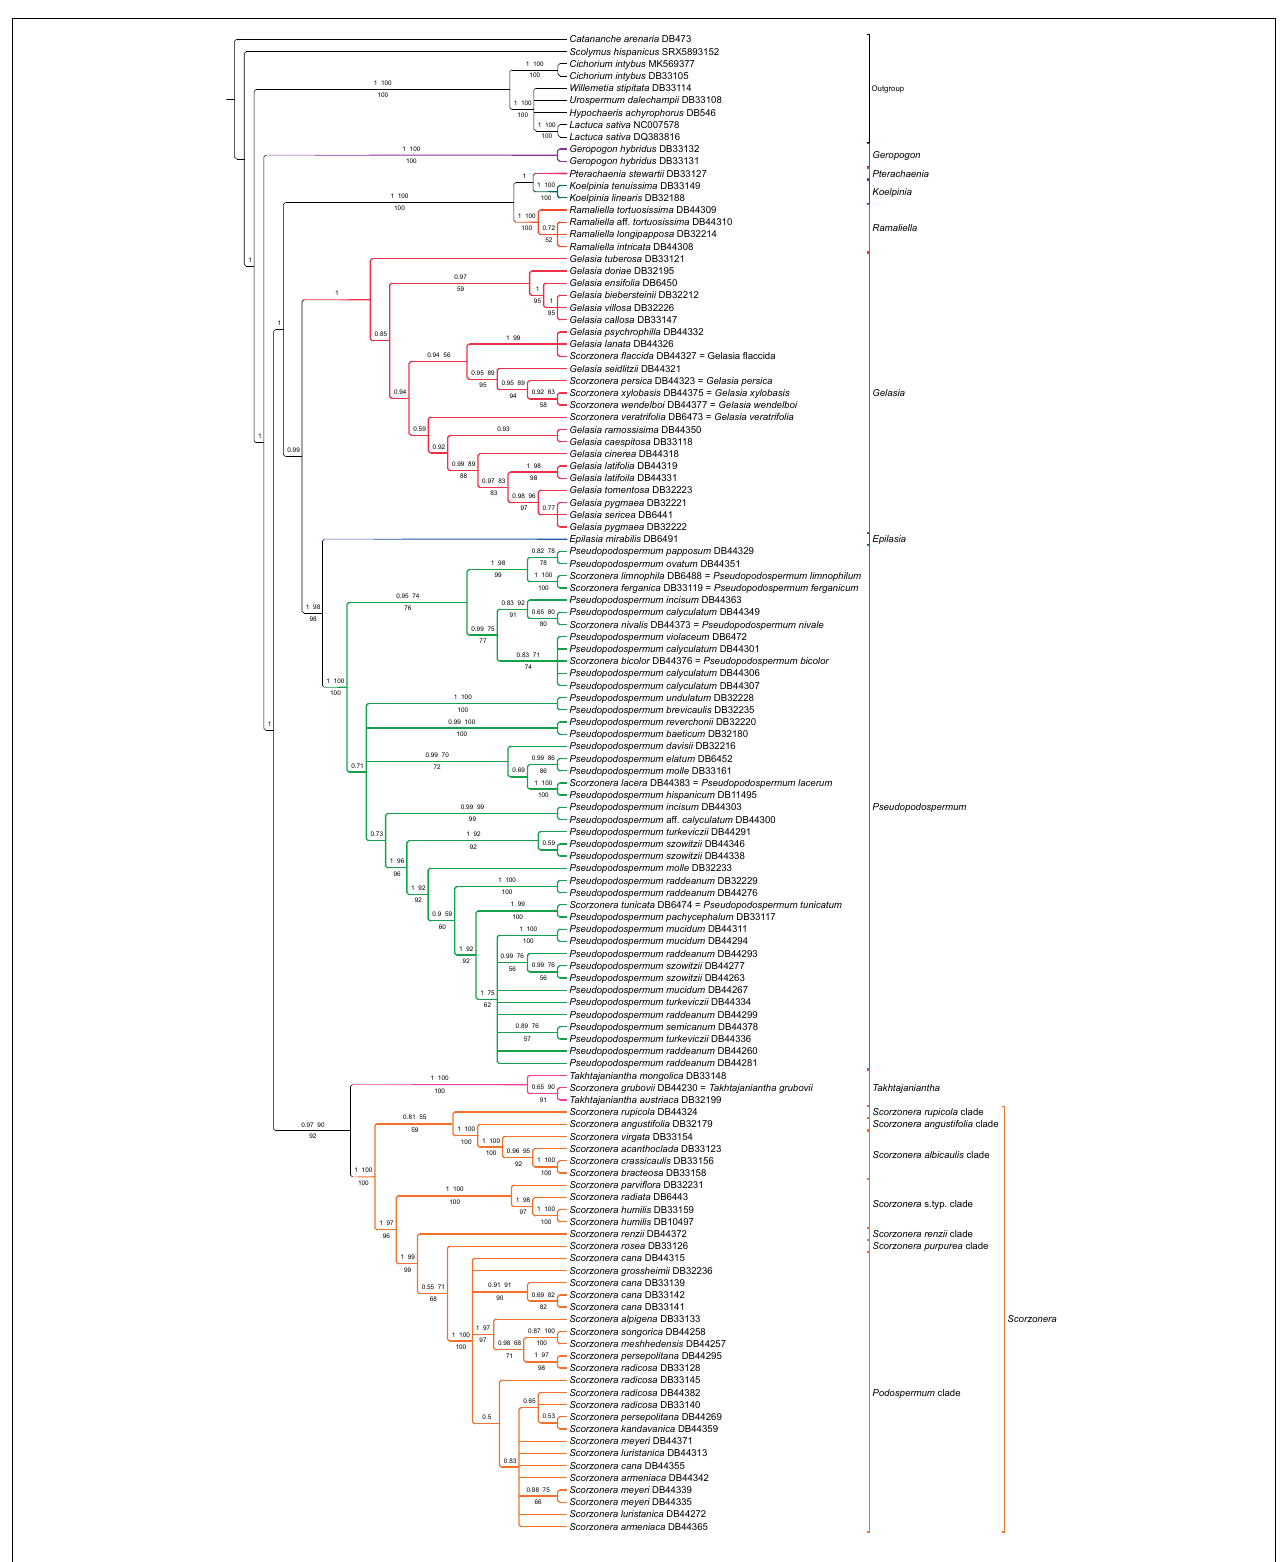
FIGURE 7 | Phylogenetic reconstruction of subtribe Scorzonerinae inferred with plastome CDS dataset under concatenation approach. Branch labels above the branches indicate posterior probabilities (PP) of Bayesian analysis and bootstrap values of ML no-partitioned analysis (BS-NP) and below the branches, bootstrap values from ML partitioned analysis (BS-P). Branches with less than 0.5 PP and 50% bootstraps (BS-NP and BS-P) are collapsed.